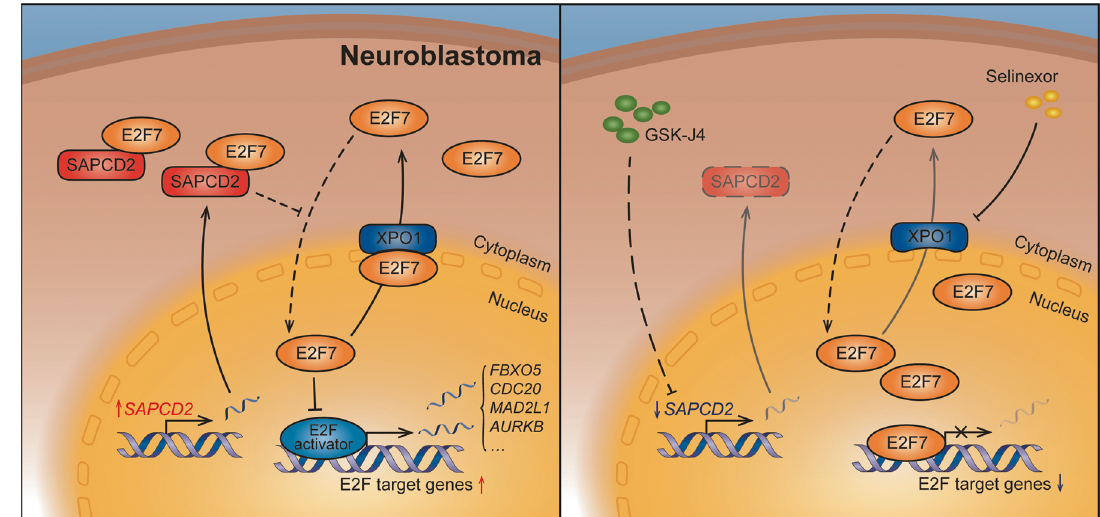
Fig. 6 A model depicting the proposed mechanism by which SAPCD2 promotes NB progression. (Left) SAPCD2 binds to E2F7 in the cytoplasm and thereby alters the subcellular distribution of E2F7, derepressing E2F signaling transactivation, and promoting NB progression. XPO1 mediates the nuclear export of E2F7 in NB cells. (Right) GSK-J4 treatment reduces the level of SAPCD2 in NB cells and limits the binding of SAPCD2 to E2F7 in the cytoplasm. Selinexor inhibits the XPO1-dependent nuclear export of E2F7. Nuclear accumulation of E2F7 inhibits the E2F signaling and suppresses the progression of NB